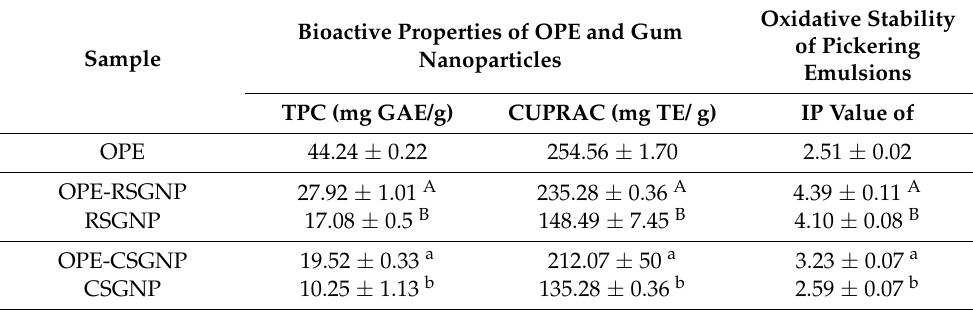
Table 5. TPC and antioxidant activity of nanoparticles and oxidative stability of Pickering emulsions prepared by